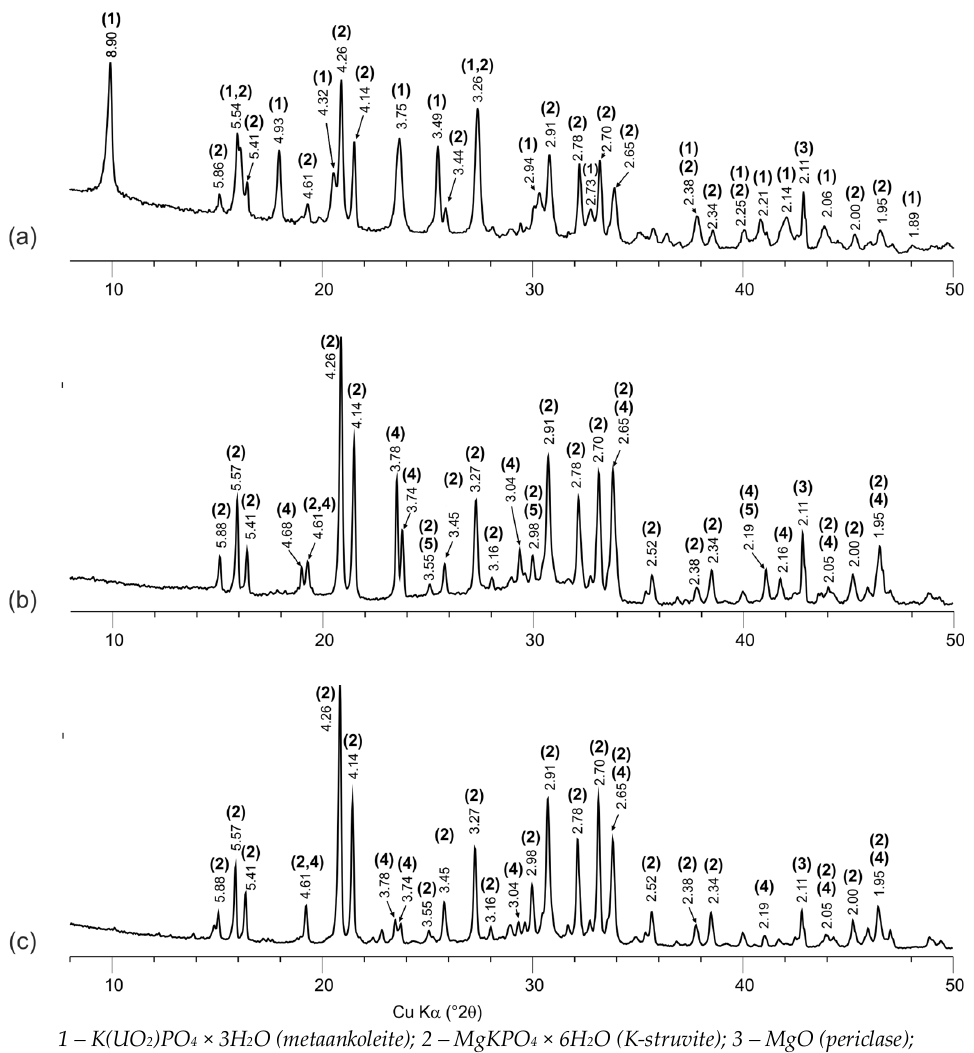
Figure 1. X-ray diffraction patterns of the compounds: #1 ( a ) and #2 ( b ), containing 6.2 wt % and 6.7 wt % uranium and lanthanum, respectively, and #3 ( c ), obtained by solidification of HLW surrogate solution.